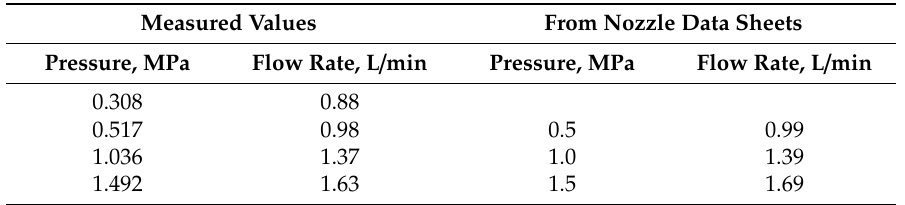
Table 1. Measured and reference flow rate values for the nozzle under test.